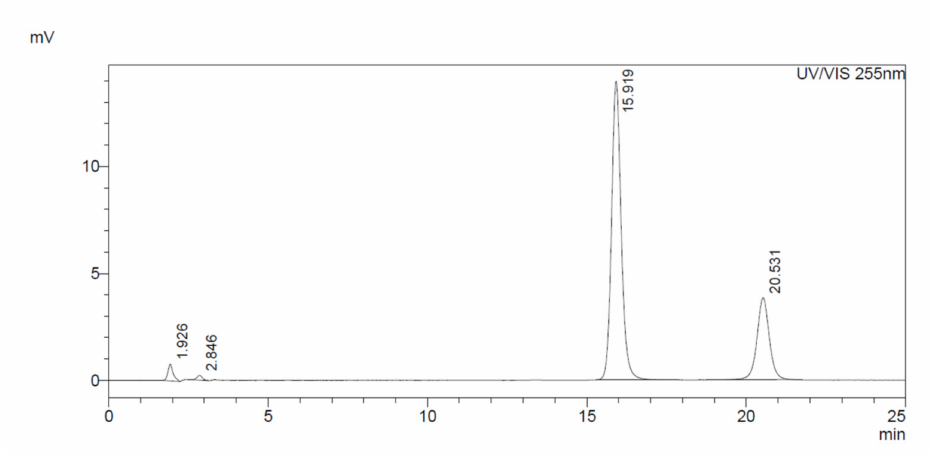
Figure 1. Chromatogram of a PBMC sample, in particular the vitamin C peak (at 20.5 min) and isoascorbic peak (IS) (at 15.9 min), spectrum taken as mass absorbance units.